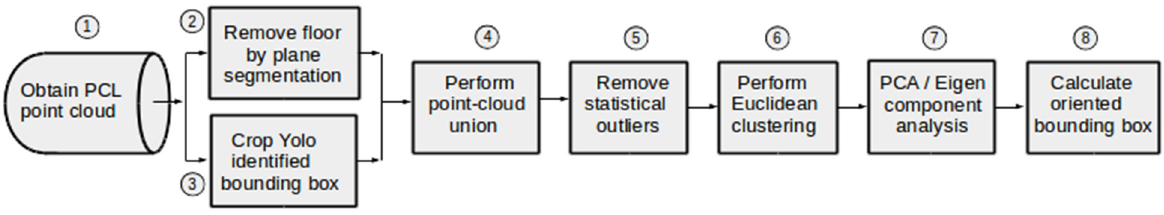
Figure 5. Point cloud isolation and boundary detection for identified objects.